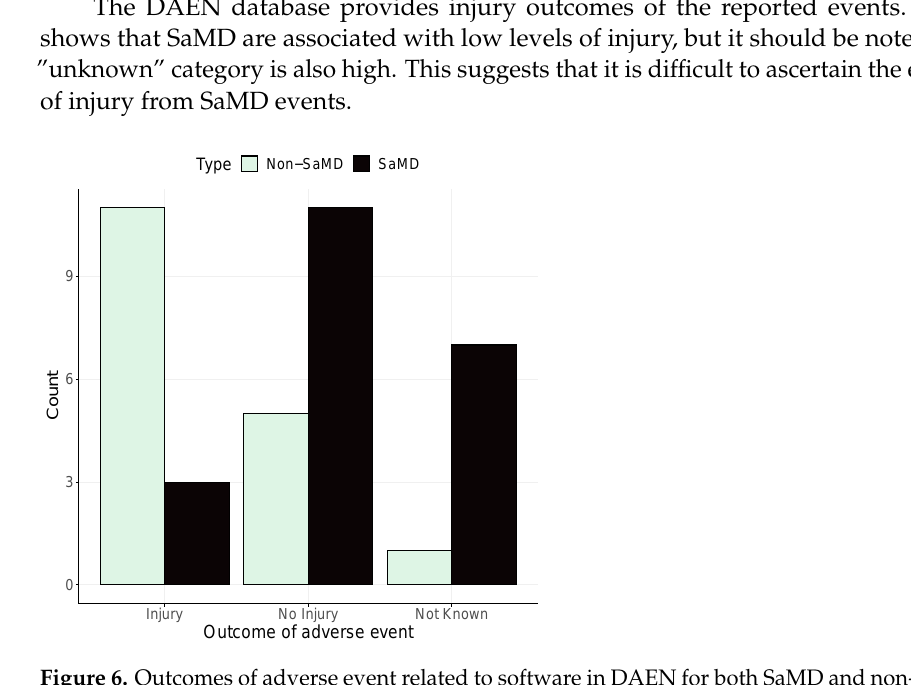
Figure 6. Outcomes of adverse event related to software in DAEN for both SaMD and non-SaMD soft-